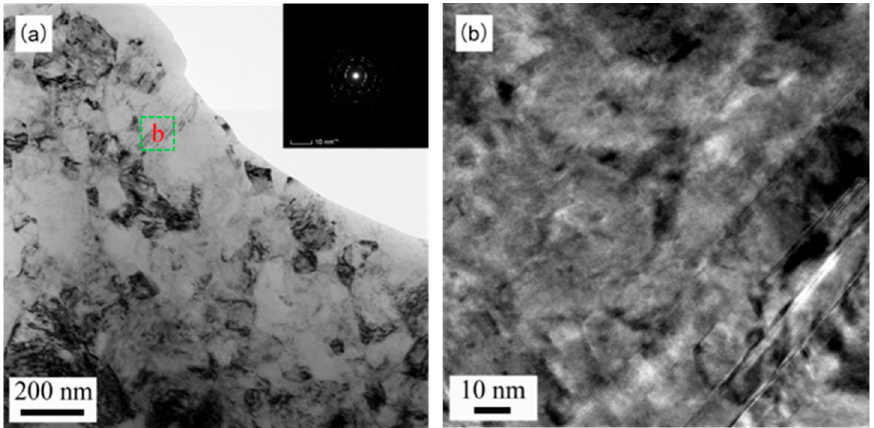
Figure 5. ( a )The top surface morphology of alloy 690 after USRT and corresponding selected area electron diffraction; ( b ) high resolution morphology of selected area in ( a ).